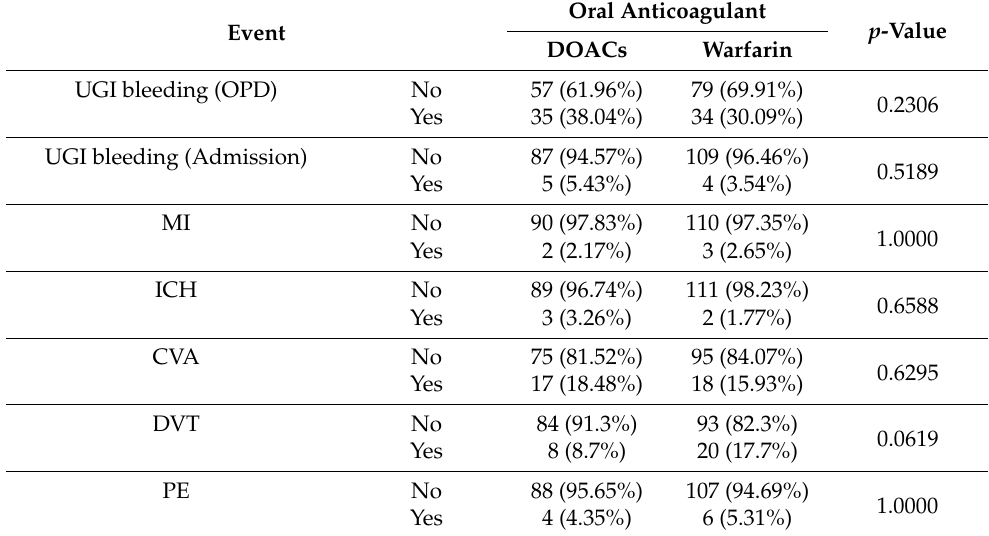
Oral Anticoagulant